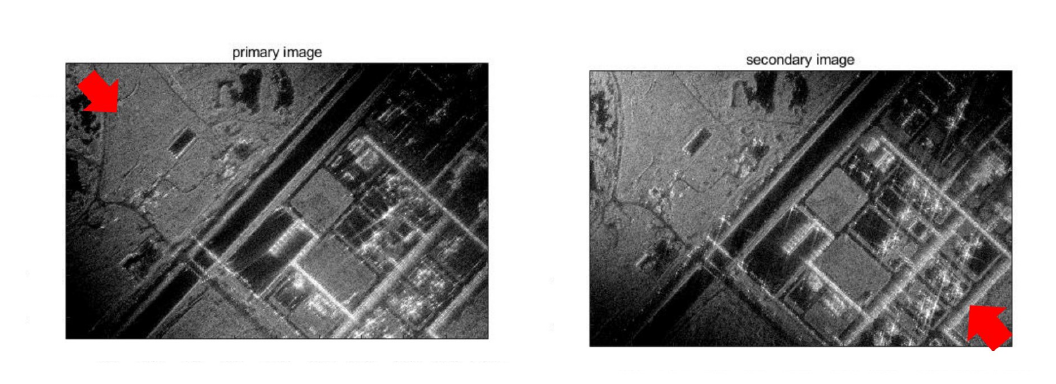
Figure 10. The first pair of images.On each sub-aperture image, the radar line of sight is indicated by red arrow.